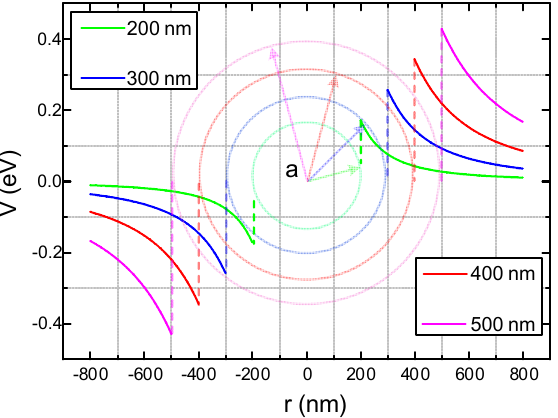
Figure 16. Electrical potential of C 60 spherical nanoparticles along the electric field E 0 and central axis.